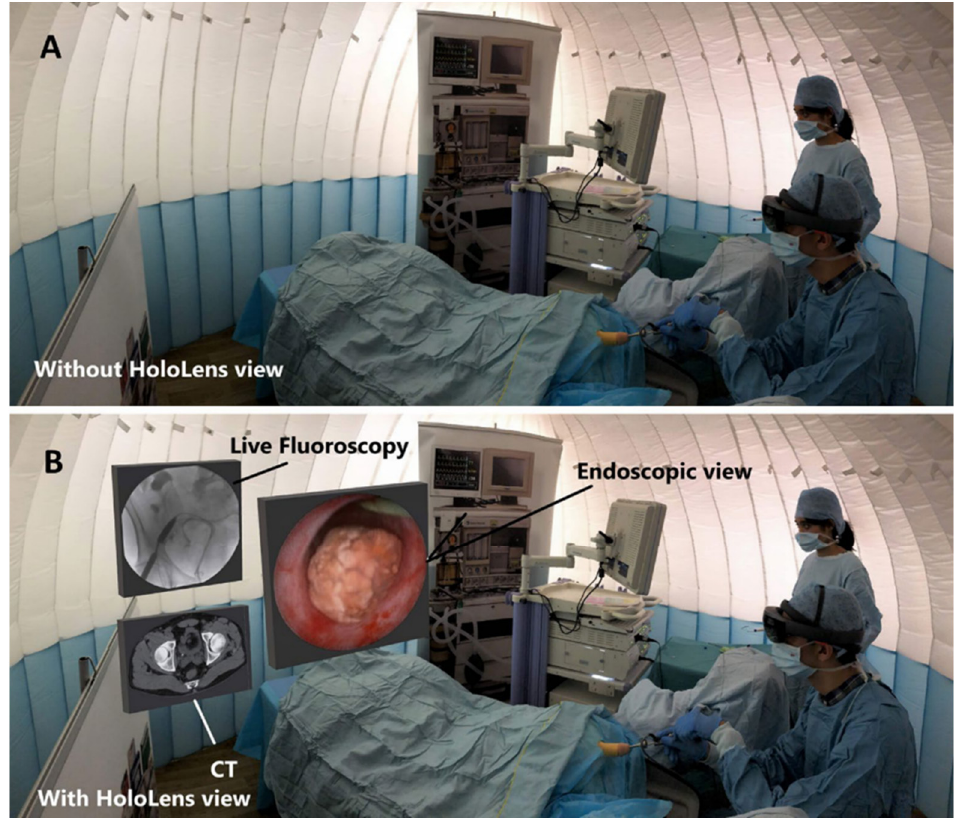
Figure 2. Scene performing ureteroscopy in full immersion simulation environment. ( A ) View of the user to a nonuser when the HoloLens is worn. ( B ) Simulated view of what the user of the HoloLens sees [3].